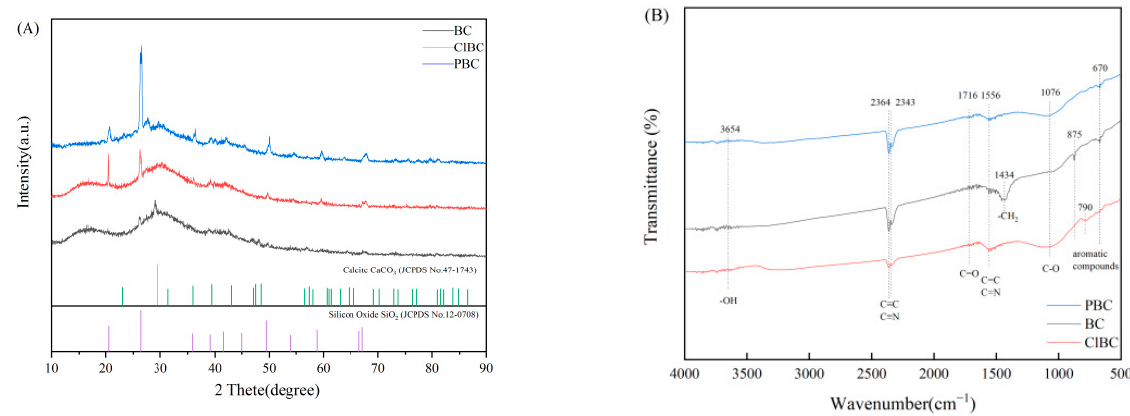
Figure 2. XRD patterns ( A ) and FT ‐ IR spectra ( B ) of BC, ClBC and PBC